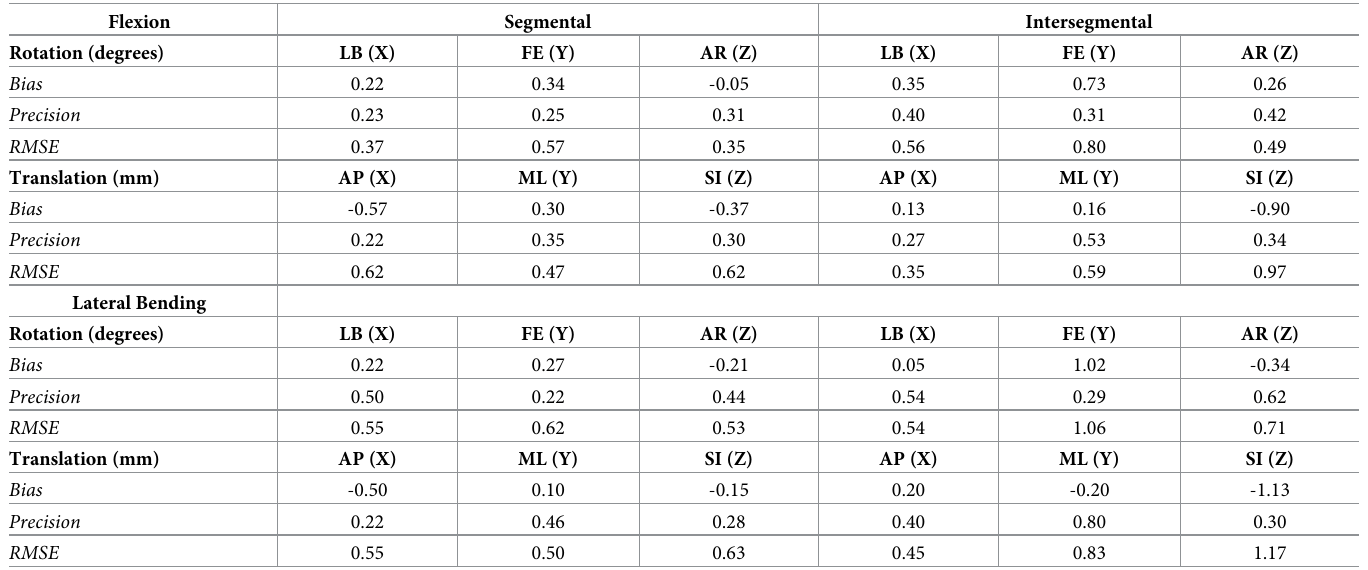
Table 2. Lumbar spine summary of means.